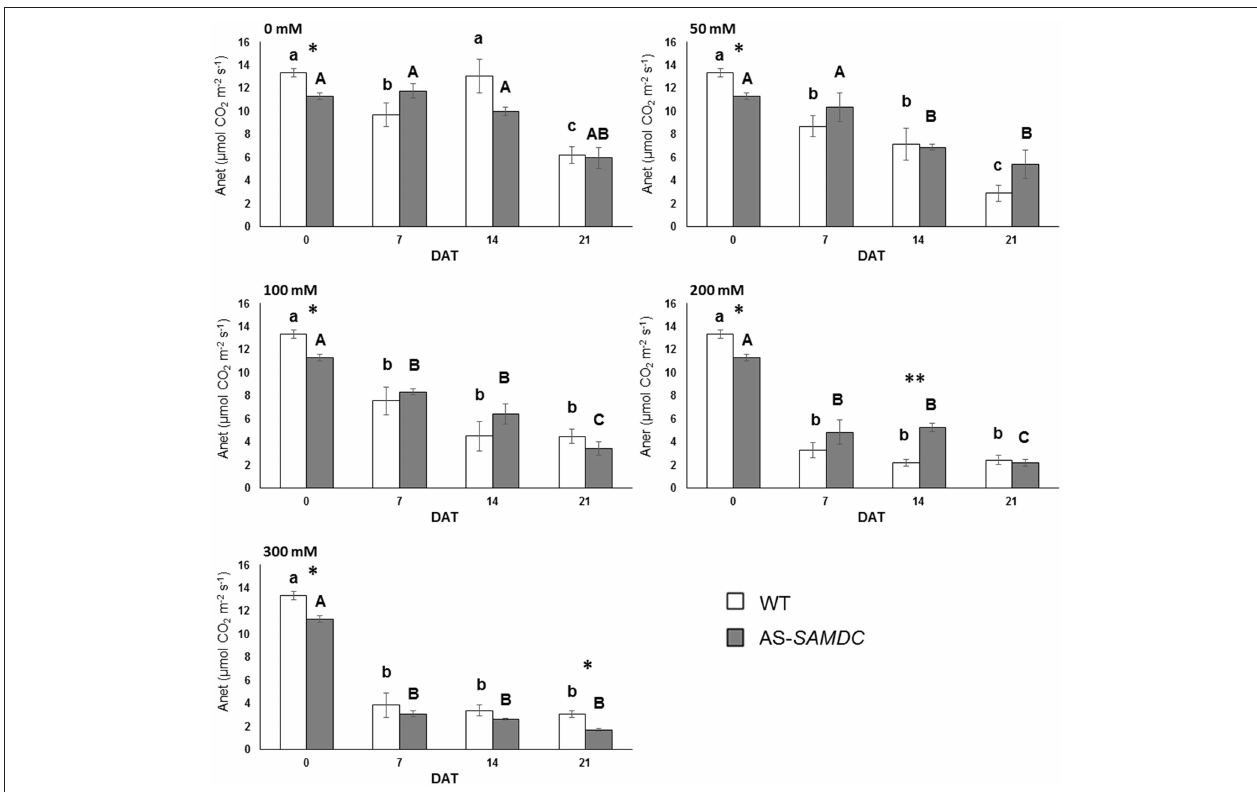
FIGURE 5 | Net photosynthesis of WT and AS- SAMDC plants under control and NaCl treatment. Net photosynthesis ( µ mol CO 2 m − 2 s − 1 ) at different NaCl concentrations (0, 50, 100, 200, 300mM), 0, 7, 14, and 21 DAT. Data are means ± SE. Different letters (lower case for WT, upper case for AS- SAMDC ) indicate significant differences over time within the same genotype, based on Tukey’s HSD test ( P < 0.05). Asterisks indicate significant difference of mean values of AS- SAMDC from WT (Student’s t-test; * P < 0.05 and ** P <